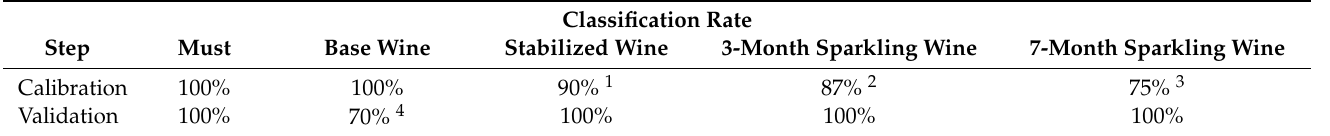
Table 4. Summary of classification results with the percentages of correctly classified samples in both calibration and validation steps using PLS-DA.